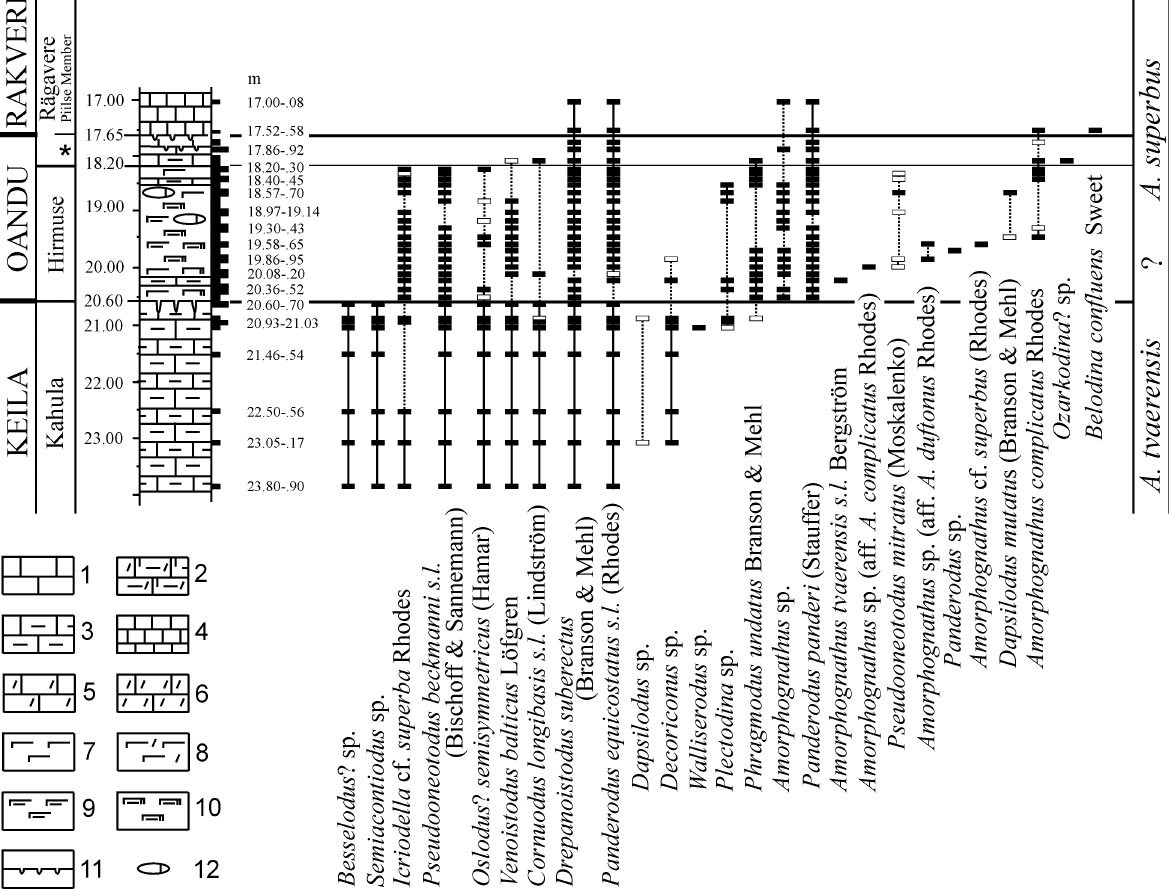
Fig. 4. Selected conodonts from the Virunurme (7721) and Ussimägi sections. As positional homology of elements in an apparatus has been determined only for few taxa, traditional Pa, Pb, Pc, M, Sa, Sb, Sc notation introduced by Sweet & Schönlaub (1975) is followed here and also in Fig. 5. Scale bar represents 100 µm. A , E , I , L , O . Icriodella cf. superba Rhodes: A, L,